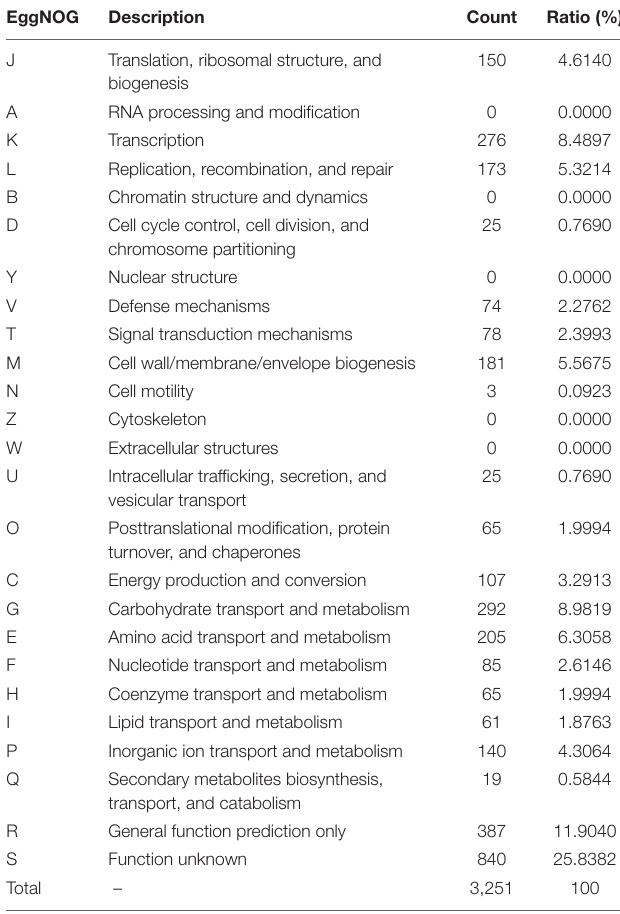
TABLE 2 | EggNOG category distribution of functional annotation